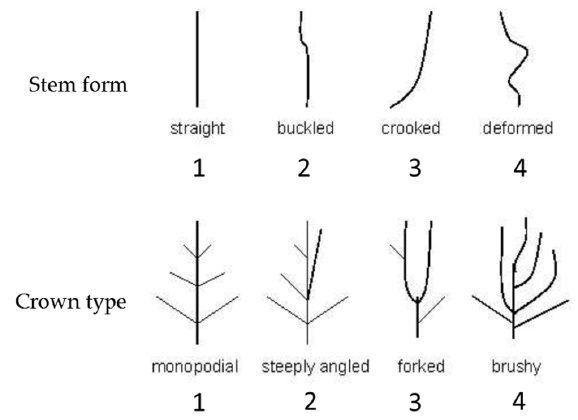
Figure 3. Morphological classification of stem form and crown type.